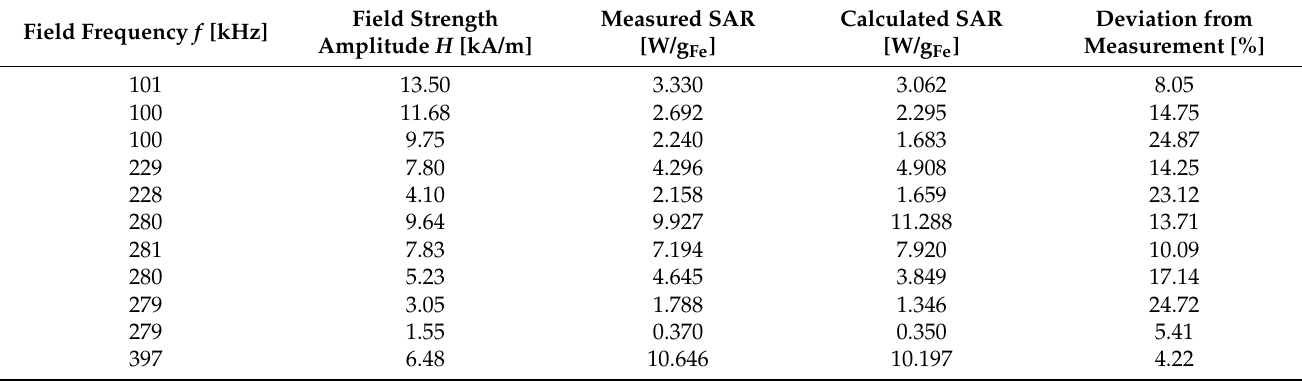
in Table 4. Table 4. Comparison of measured and calculated SAR values at given magnetic field frequency and